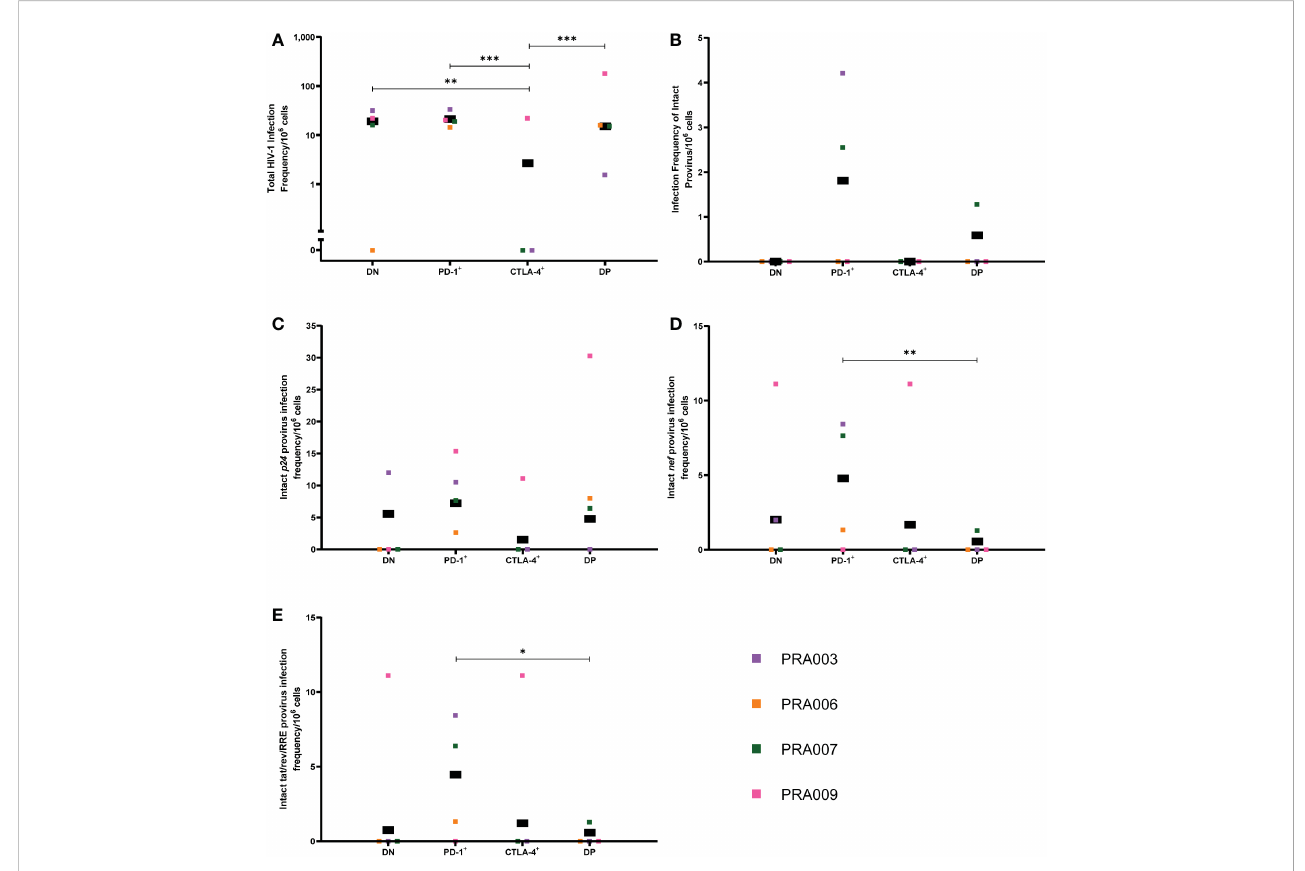
FIGURE 6 Frequency of HIV-1 proviruses in lymph node memory CD4 + T-cells expressing PD-1 and/or CTLA-4. The HIV-1 infection frequency per 10 6 cells of total HIV-1 proviruses (A) , genetically-intact proviruses (B) , proviruses with an intact p24 ORF (C) , proviruses with an intact nef ORF (D) and proviruses with an intact tat/rev/RRE ORF (E) in DN, PD-1 + , CTLA-4 + and DP cells from the lymph node. Data is the estimated infection frequency per 10 6 cells for each subset. p-values represent evidence for an overall trend of a difference between subsets within these participants (mixed effects logistic regression), * p ≤ 0.05, ** p ≤ 0.01, *** p ≤